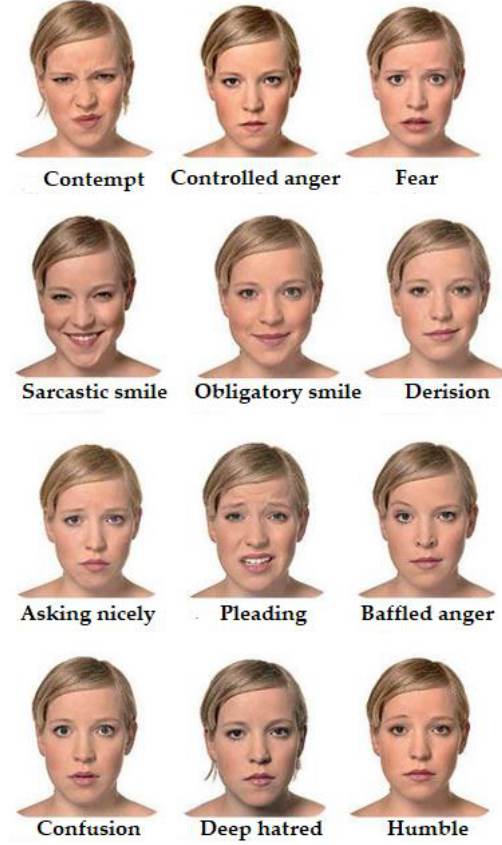
Figure 37. Facial expressions. Figure 37. Facial